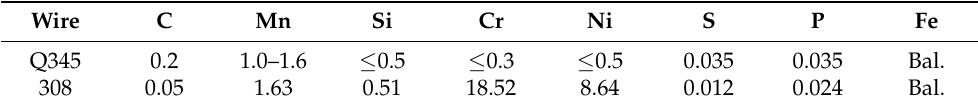
Table 1. The composition of 308 and Q345 wire